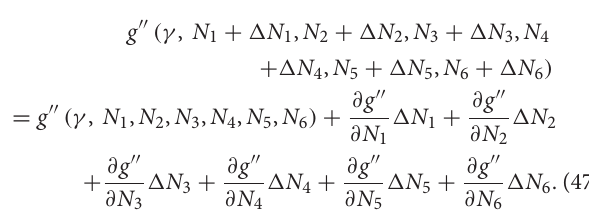
Expanding Equation (46) about γ =